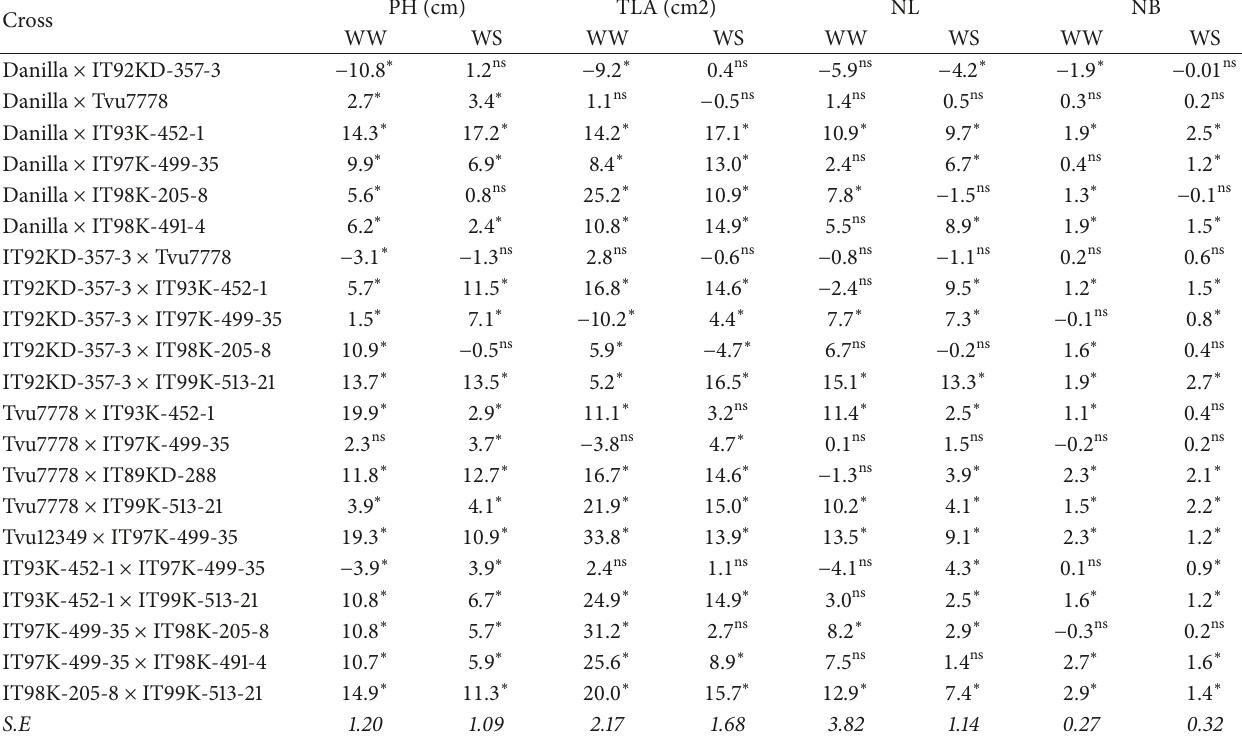
Table 4: Specific combining ability effects for different morphological characteristics in cowpea in water-stressed (WS) and well-watered (WW)